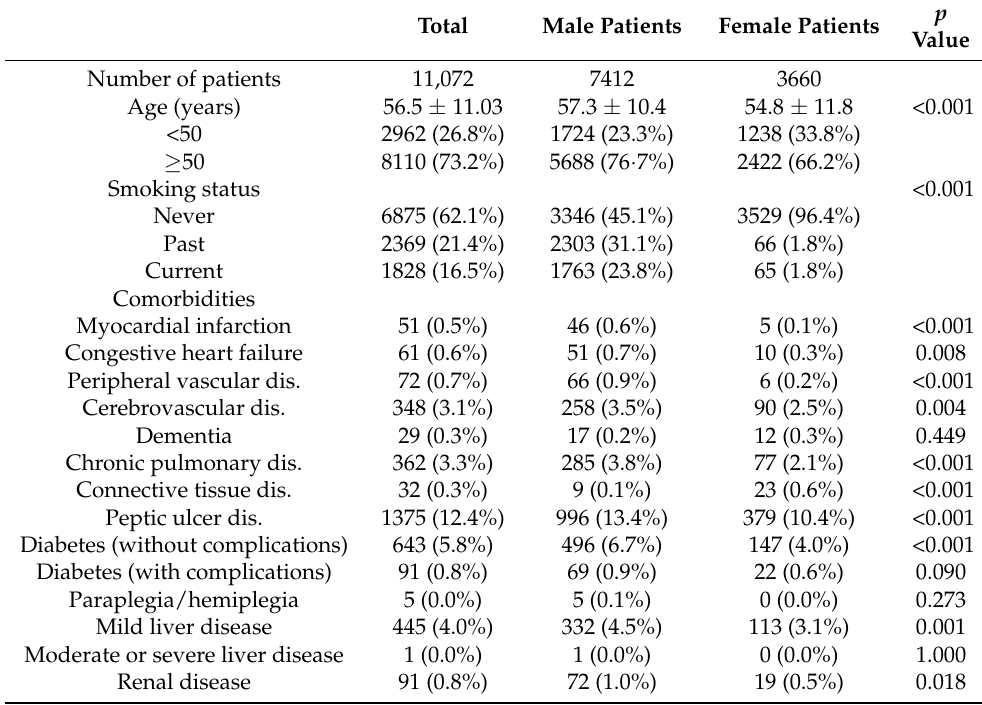
Table 1. Baseline characteristics of patients in the study